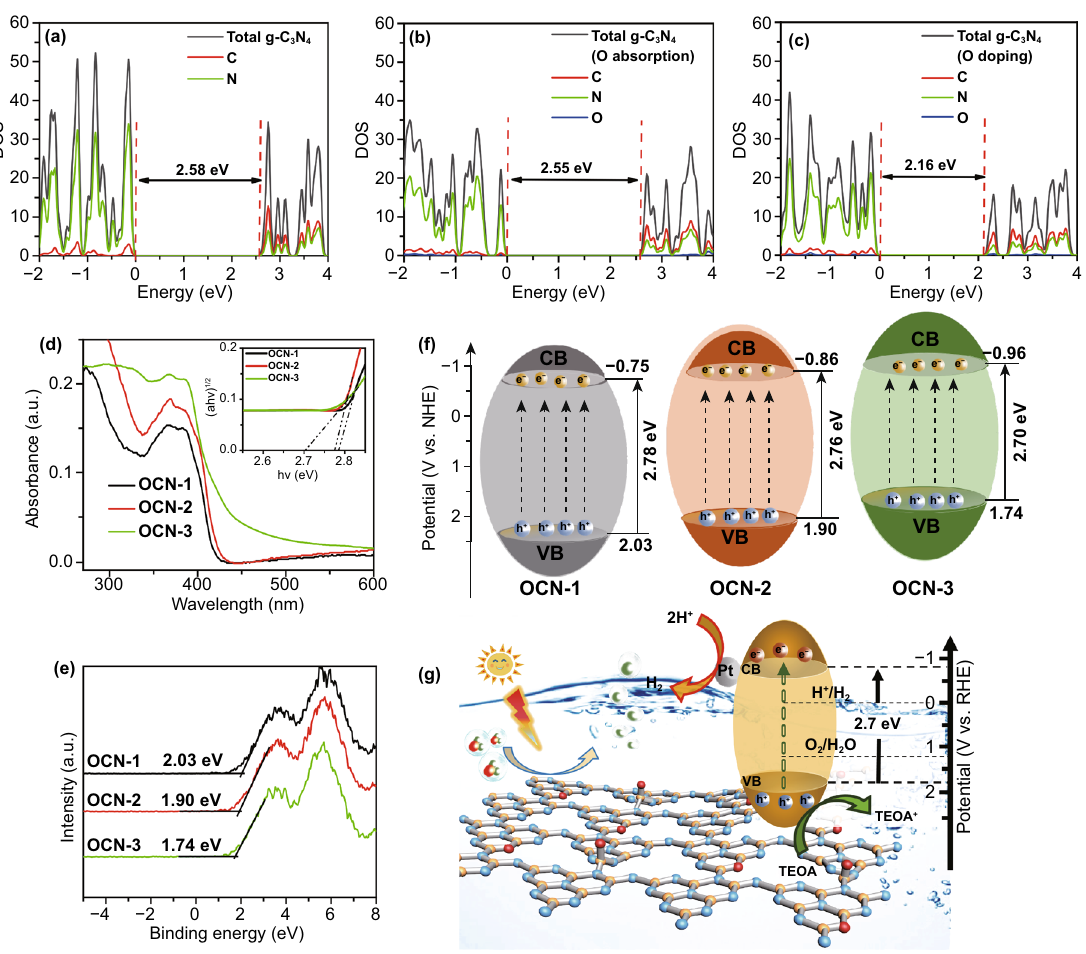
Fig. 5 a Density of state (DOS) of pristine g-C 3 N 4 , b O-doped g-C 3 N 4 , and c O-adsorbed g-C 3 N 4 . d UV–visible absorbance spectra, e VB-XPS survey, and f energy level diagrams, g photocatalytic H 2 -production mechanism of OCN-1, OCN-2,